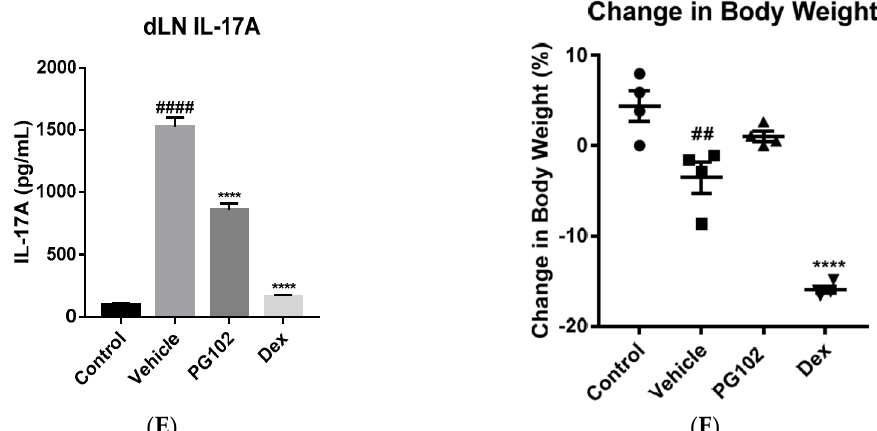
Figure 2. Topical treatment of PG102 alleviates imiquimod (IMQ)-induced psoriasis-like symptoms. ( A ) Experimental scheme ( B ) Photo of dorsal skin of Control (DMSO only), Vehicle (IMQ + DMSO), PG102 (IMQ + PG102 100 mg/kg) and Dexamethasone (IMQ + Dex 1 mg/kg) treated mice. ( C ) Psoriasis Area and Severity Index (PASI) scoring. ( D ) Hematoxylin-eosin (H&E) staining of dorsal skin (200×). ( E ) Interleukin (IL)-17A protein level from phorbol 12-myristate 13-acetate (PMA)/ionomycin-restimulated cells isolated from draining lymph nodes. ( F ) Change in body weight. Representative results from at least three independent experiments are shown ( n = 3–4). The data are shown as the mean ± standard error of mean (SEM). ## p < 0.01, #### p < 0.0001 versus Control group; * p < 0.05, ** p < 0.01, *** p < 0.001, **** p < 0.0001 versus vehicle group.